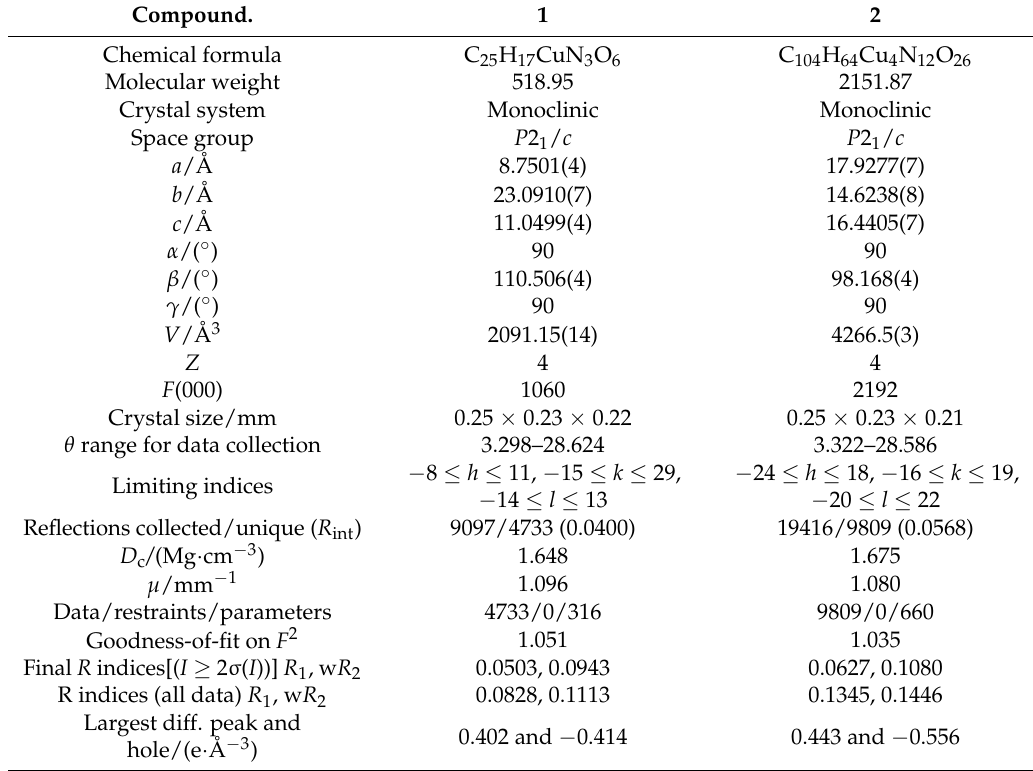
Table 2. Crystal data for compounds 1 and 2